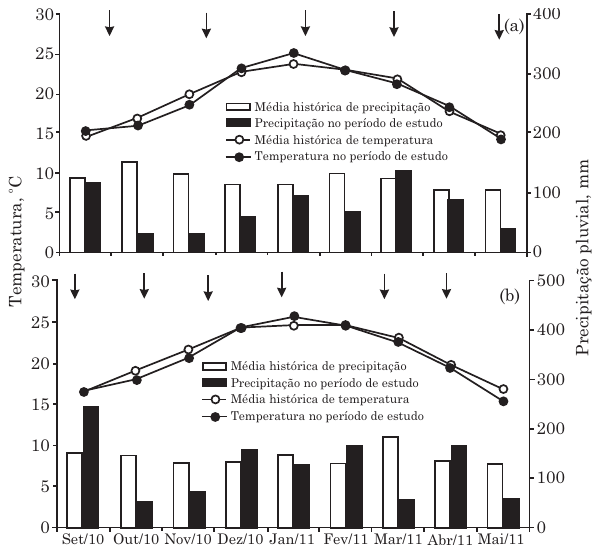
Figura 1. Temperatura média e precipitação média nas áreas experimentais de (a) Candiota (experimentos I e II) e (b) Santa Maria (experimento III). Primeira flecha indica data de aplicação das fontes de fosfato (início do experimento) e as demais indicam as datas das avaliações da massa de